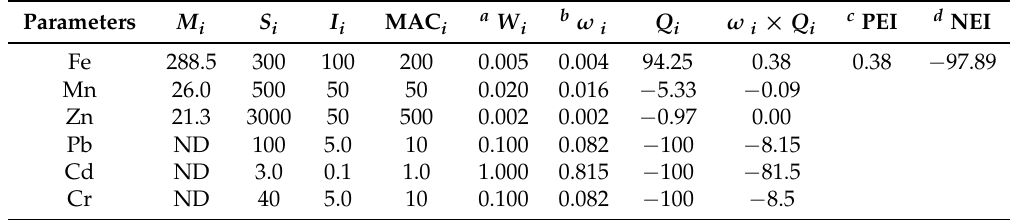
Table 7. Standard values of corresponding heavy metals ions and calculation of MHEI for groundwater samples (GW01 as an example) of the study area.